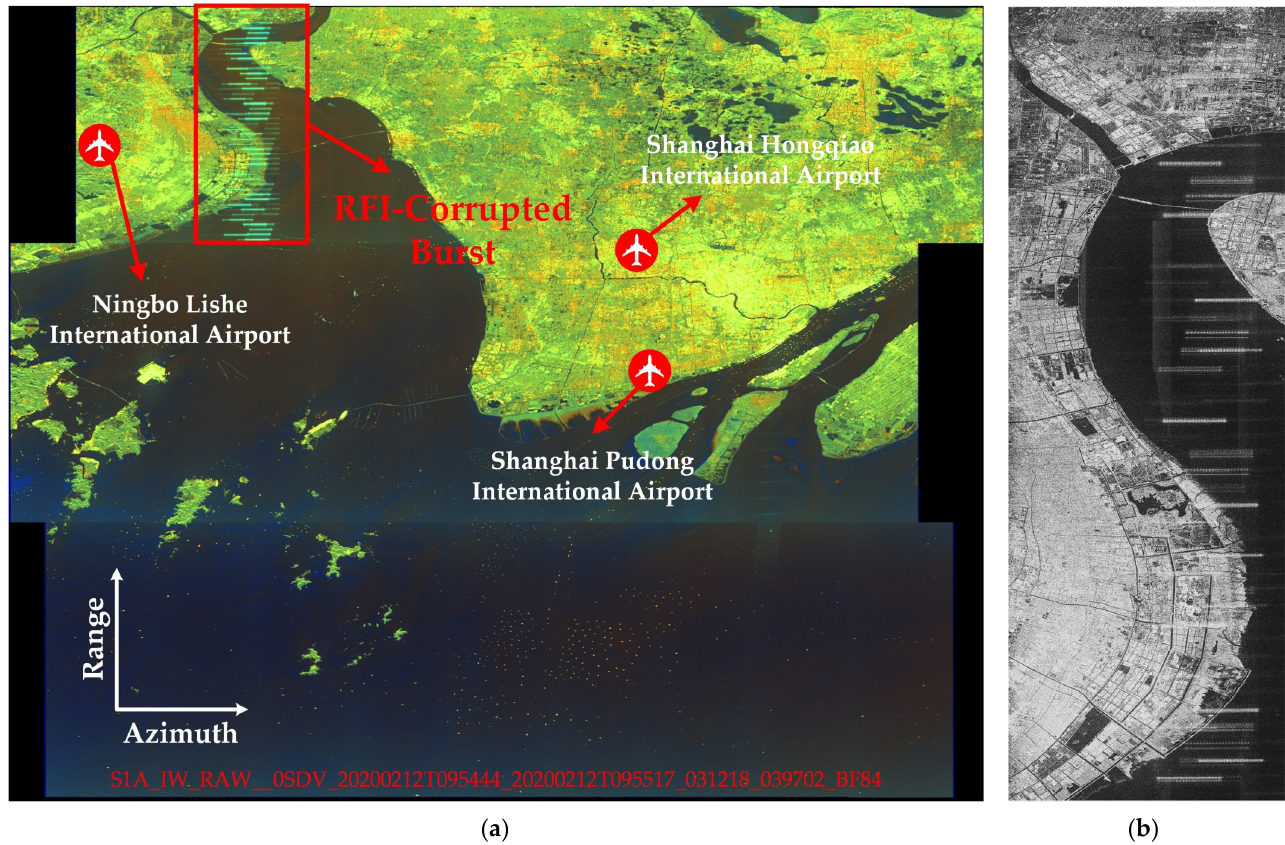
Figure 10. RFI-contaminated image of the measured Sentinel-1 level-0 raw data: ( a ) The pseudo color image of the measured Sentinel-1 level-0 raw data; ( b ) The RFI-corrupted burst.